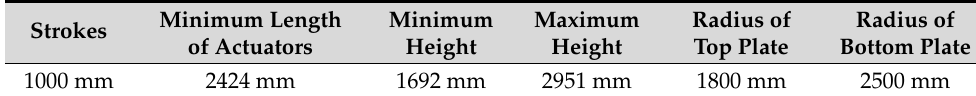
Figure 8. Dimensions of the motion platform. Table 1. Kinematic limit range of the motion